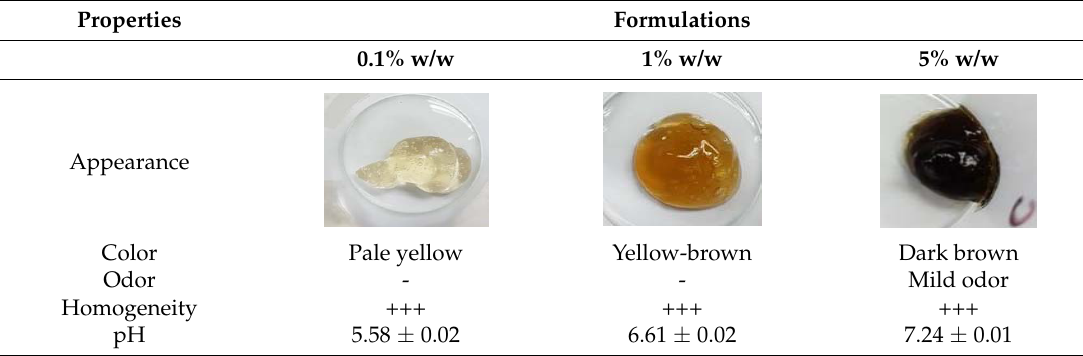
Table 1. Physicochemical properties of gel formulations containing the herbal ball extract at the concentration of 0.1, 1 and 5% w/w. Note: homogeneity was graded as +++ good, ++ fair and + poor.